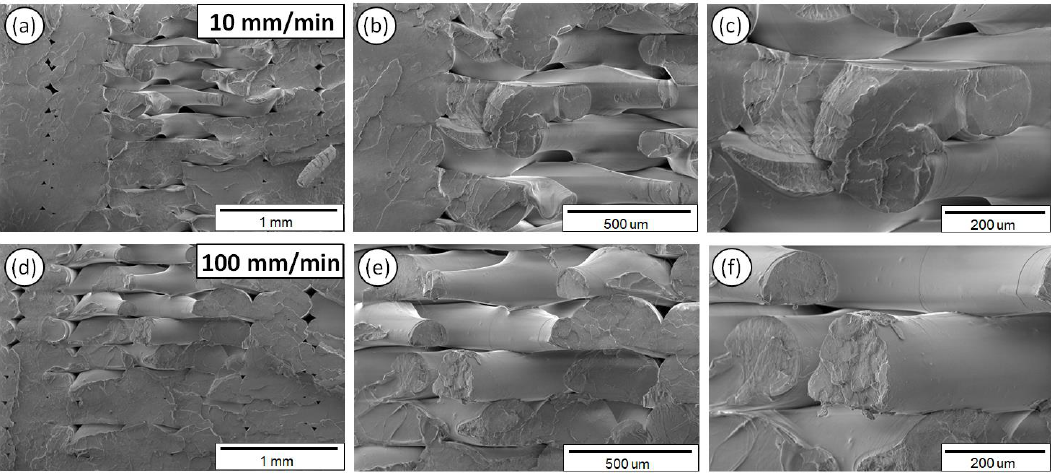
Figure 8. SEM images of PLA fractured surfaces at three different magnifications for the 10 ( a , b , c ) and 100 mm/min ( d , e , f ) strain rates.